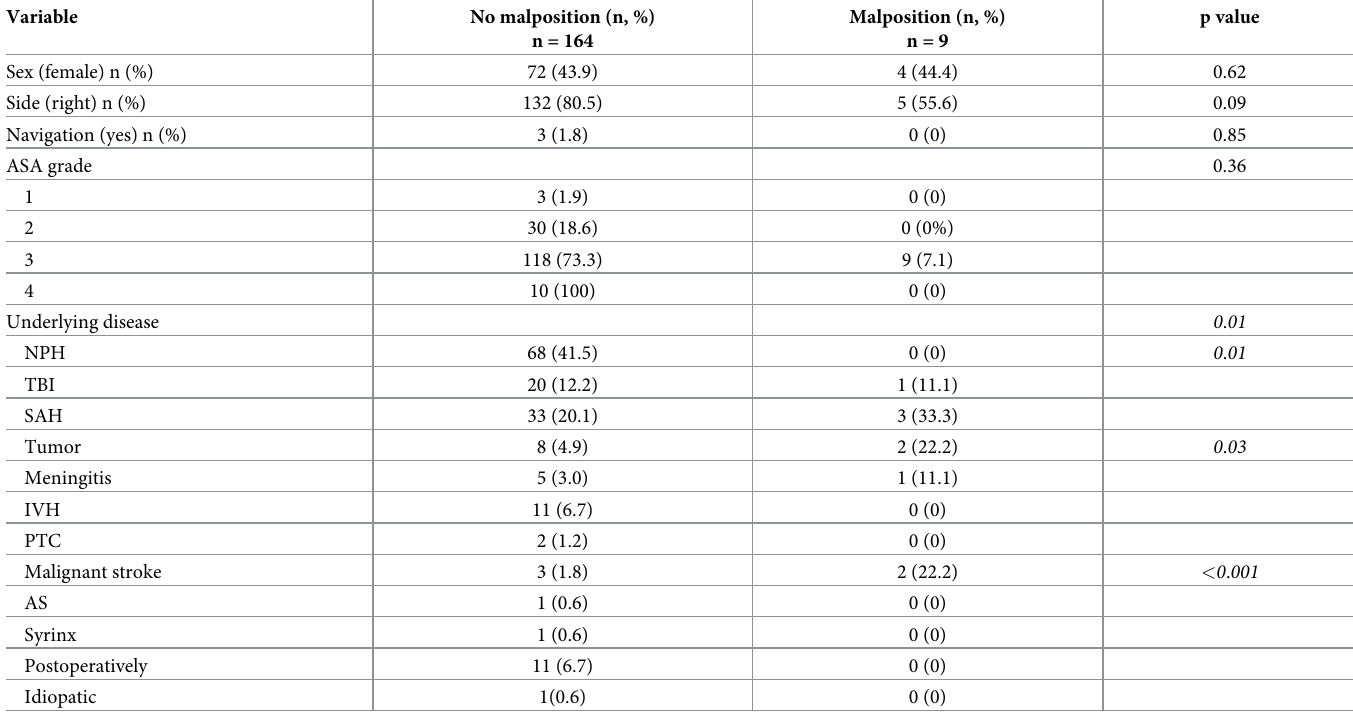
Table 5. Comparison of cohort demographics between patients with and without shunt